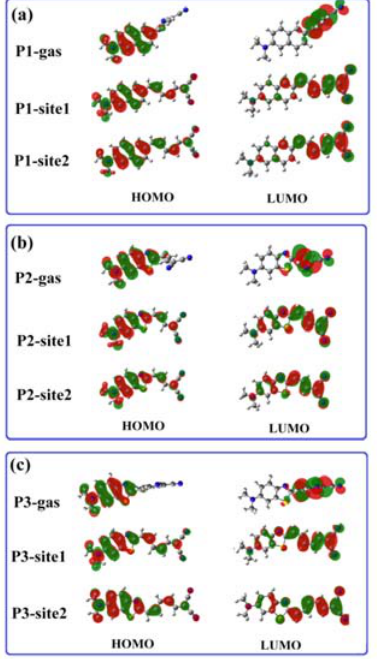
Figure 7. HOMO and LUMO for ( a ) P1, ( b ) P2, and ( c ) P3 in the first excited state in different microenvironments.